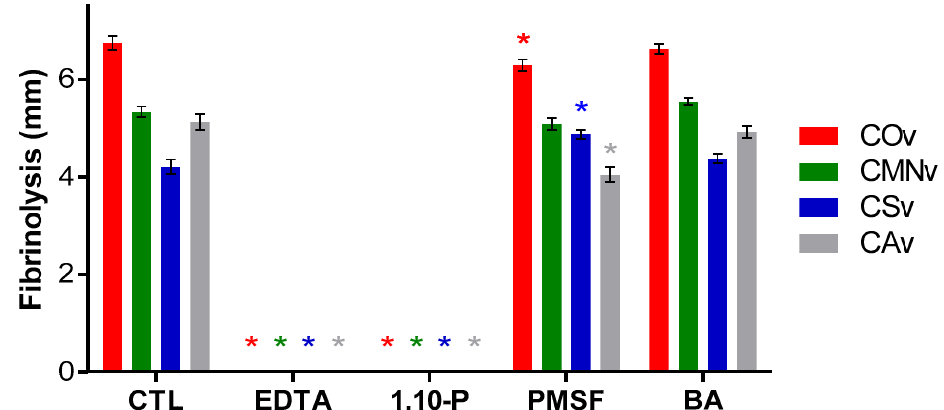
Figure 7. Fibrinolytic activity for Crotalus venoms. 10 µg of C. ornatus (COv), C. m. nigrescens (CMNv), C. scutulatus (CSv), and C. atrox (CAv) venoms were preincubated without inhibitor (CTL) or with 5 mM of each inhibitor: EDTA, 1,10-P, PMSF, or BA, for 10 min at 37 °C prior to the assay. Fibrinolytic activity is presented as the mean of at least three independent experiments with its respective standard error, statistically significant difference ( p < 0.05) with respect to control for each venom is represented with an asterisk (*).